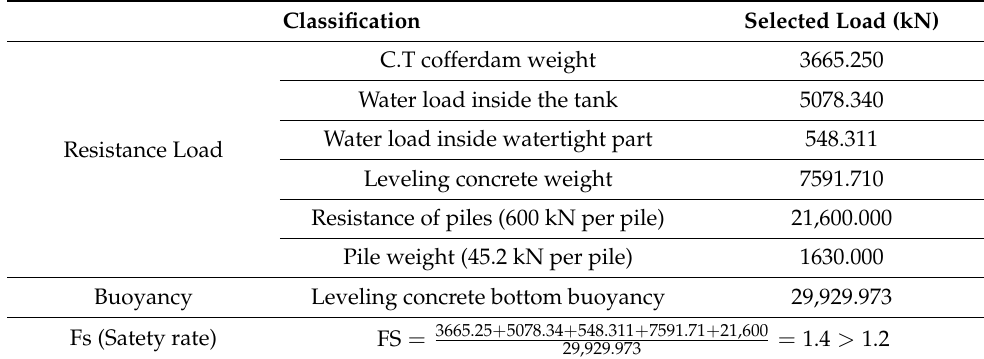
Table 2. Stability review for the buoyancy of C.T cofferdam.